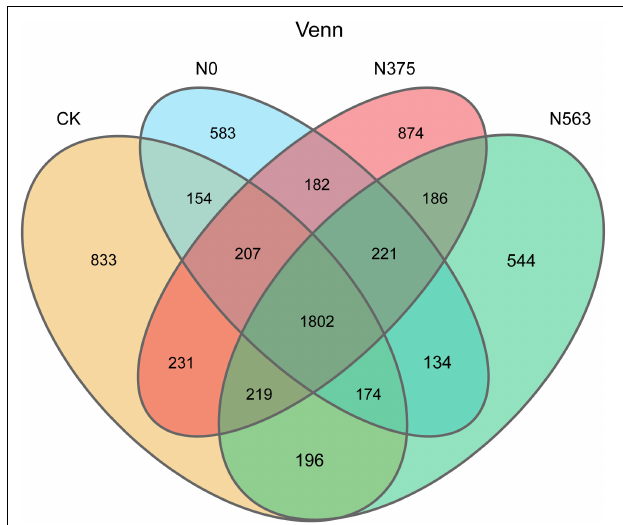
FIGURE 1 | A Venn diagram demonstrating the unique and common bacterial OTUs among the four treatments. CK, without fertilization; N0, without N fertilization; N375, application of 375 kg/ha N; N563, application of 563 kg/ha N.